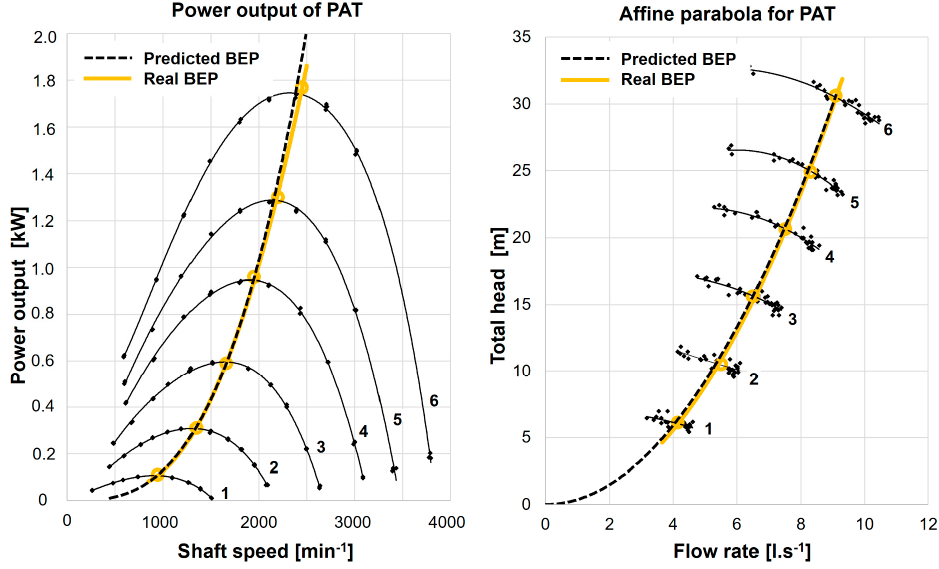
Figure 7. Predictive calculations of power output and affine parabola versus reality.